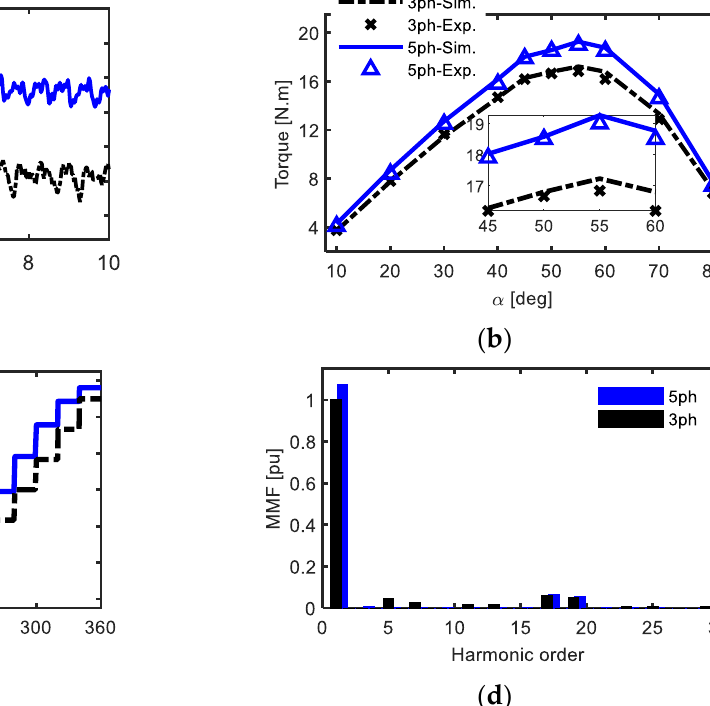
Figure 16. The performance comparison of the proposed drive with the conventional three-phase drive at rated conditions. ( a ) Simulated torque versus time at the optimal current angle, ( b ) measured and simulated results for the average torque versus current angle, ( c ) MMF magnitude, and ( d ) MMF harmonic spectrum.